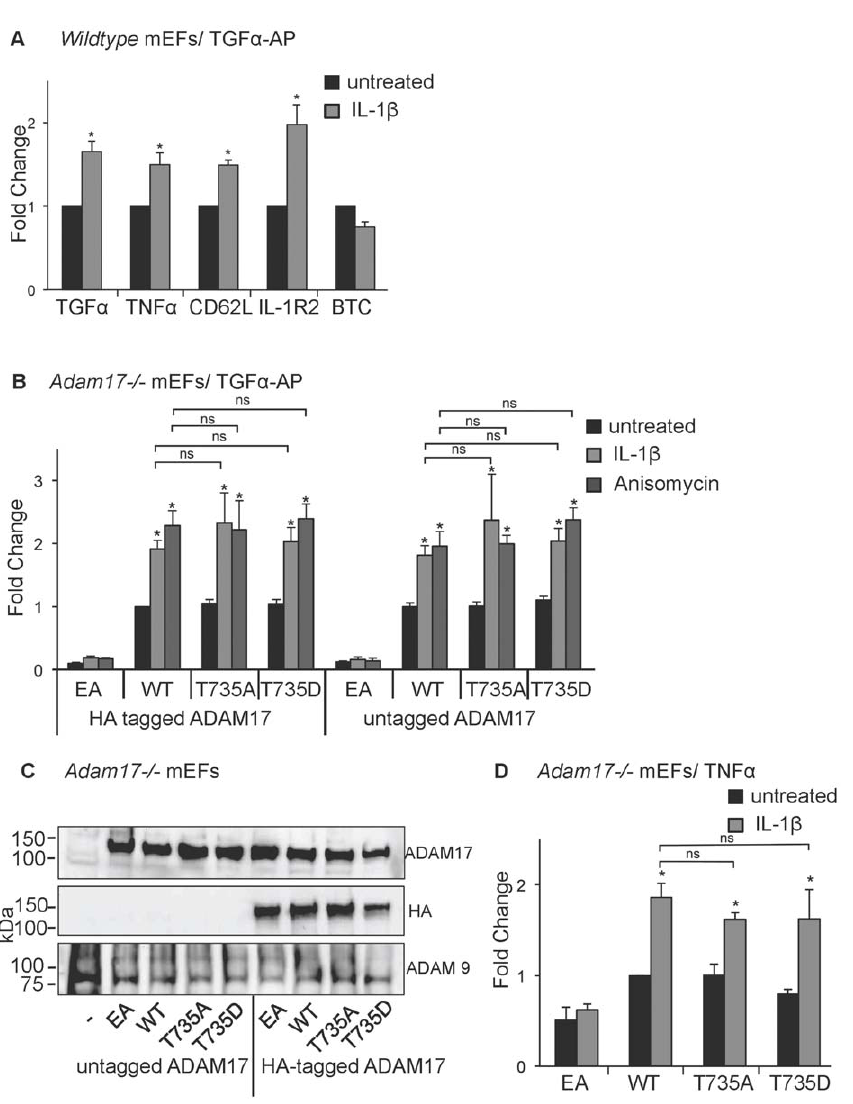
Figure 1. Stimulation of wild type and T735 mutant forms of ADAM17 by IL-1ß and anisomycin. A) Wild type mEFs were transfected with alkaline phosphatase-tagged substrates to monitor the sheddase activity of ADAM17 (TGF a , TNF a , CD62L and IL-1R2) or ADAM10 (BTC) and stimulated with IL-1ß (5 ng/ml) for 30 minutes. The release of the AP-tagged ADAM10 or ADAM17 substrates into the culture supernatant was determined as described in materials and methods. B) Adam17 2 / 2 primary mEFs were transfected with TGF a -AP and either HA-tagged or untagged forms of the catalytically inactive ADAM17-E406A (EA), wild type ADAM17 (WT), or ADAM17 carrying point mutations at residue T735 (T735A or T735D), as indicated. The amount of TGF a -AP released in 30 minutes from untreated cells (black bars) or from cells stimulated with IL-1ß (5 ng/ml, light grey bars) or anisomycin (1 m M, dark grey bars) was determined as described in materials and methods. C) Western blots of untagged or HA- tagged forms of ADAM17 (EA, WT, T735A or T735D) expressed in Adam17 2 / 2 mEFs were probed with antibodies against the cytoplasmic domain of ADAM17 (top panel) or the HA-tag (middle panel), or against ADAM9 as a loading control. D) Shedding of transfected human TNF a from Adam17 2 / 2 mEFs rescued with WT or the T735A, T735D or EA mutant forms of ADAM17. The amount of TNF a released into the conditioned media from unstimulated cells or cells stimulated with IL-1 b (5 ng/ml) in 30 minutes was determined by ELISA. All data represent the average of at least three separate experiments, and the error bars correspond to + / 2 standard error of the mean (sem). Asterisks indicate a significant increase upon addition of the stimulatory agent (students t-test, p , 0.05). NS indicates that no significant difference was found between the indicated conditions.